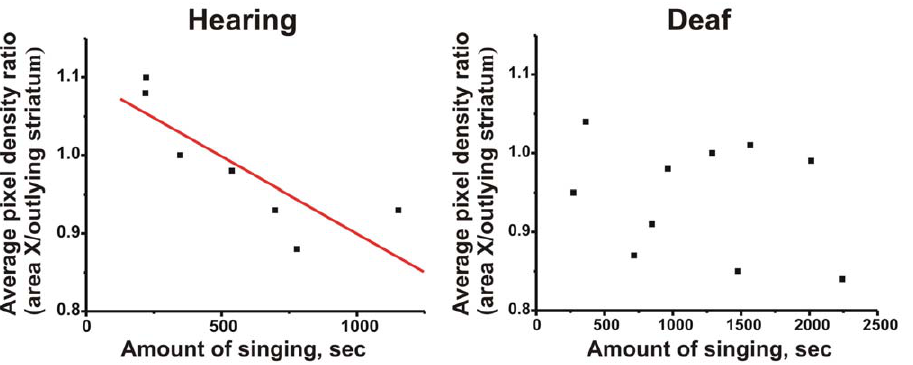
Figure 4. Hearing links amount of singing with FoxP2 levels. The amount of time that 75d birds spent singing (x axis) and area X FoxP2 levels measured using the mid-probe (y axis) are correlated in hearing (left; Spearman Rho= 2 0.86, R 2 =0.69; p , 0.02), but not in deaf (right; Spearman Rho= 2 0.19, R 2 =0.04; p =0.60), juveniles.